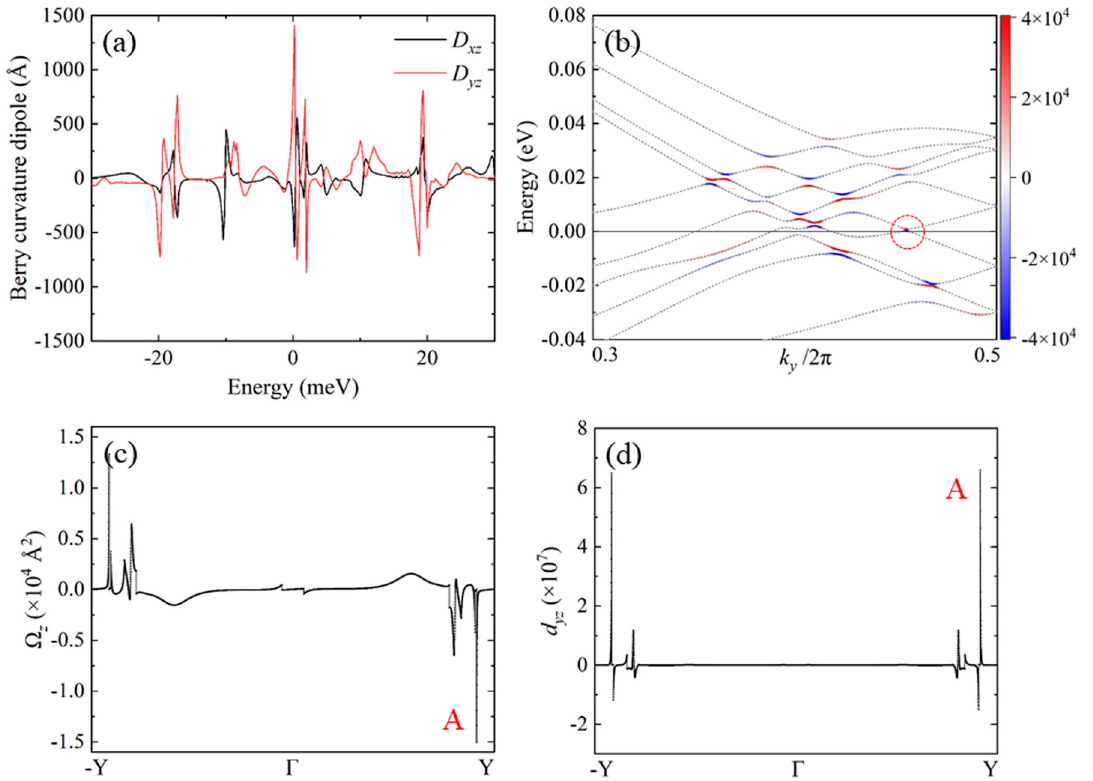
Fig. 3 Nonlinear Hall effect in twisted bilayer WTe 2 . a The Fermi energy dependence of Berry curvature dipole for twisted bilayer WTe 2 ( θ = 29.4°). b Band structure and Berry curvature Ω nk ; z (Å 2 ) along Γ -Y line. The calculated Fermi level is set to be zero. c , d Berry curvature Ω z and Berry curvature dipole density d yz along Y- Γ -Y line, respectively.